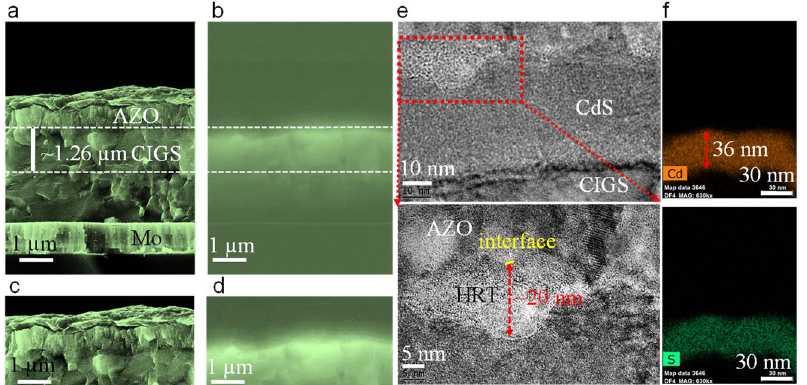
Figure 4. ( a ) Cross−sectional SEM image of CIGS solar cell. ( b ) Corresponding EBIC image of CIGS solar cell. ( c ) Cross−sectional SEM image of CIGS/CdS/i−ZnO/AZO interfaces. ( d ) Corresponding EBIC image of CIGS/CdS/i−ZnO/AZO interfaces. ( e ) High−resolution transmission electron microscopy (HRTEM, upper), and magnified HRTEM (down) images of AZO/high resistive layer (HRT)/CdS in the CIGS solar cell. ( f ) EDX mapping of CdS in CIGS solar cells, indicating the thickness of CdS is about 36 nm.